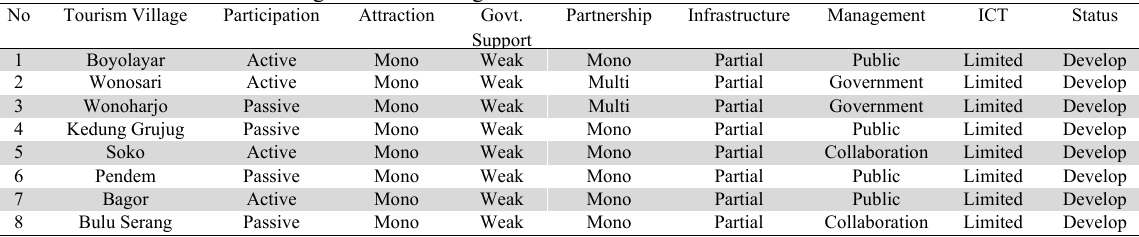
Profile and Status of Tourist Villages in the Kedung Ombo Area